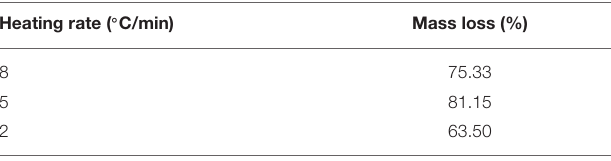
TABLE 1 | Mass losses of sisal hemp pulp-based paper at 280–400 ◦ C at different heating rates (8, 5, and 2 ◦ C/min).